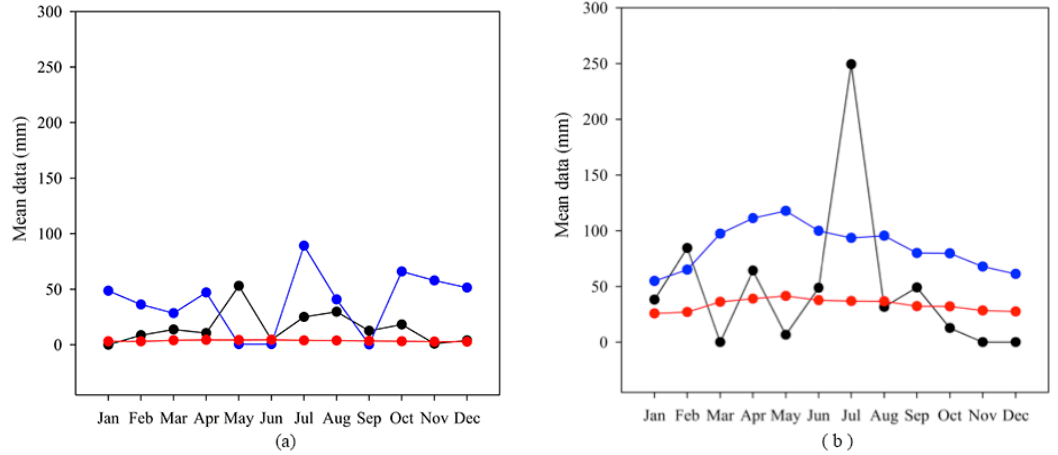
Figure 5. ( a ) Temporary progression of the rainfall ( R ) ( • ), consumptive use ( U ) ( • ), and potential evapotranspiration ( PE m ) ( ) in 1982 and ( b ) in 2010.